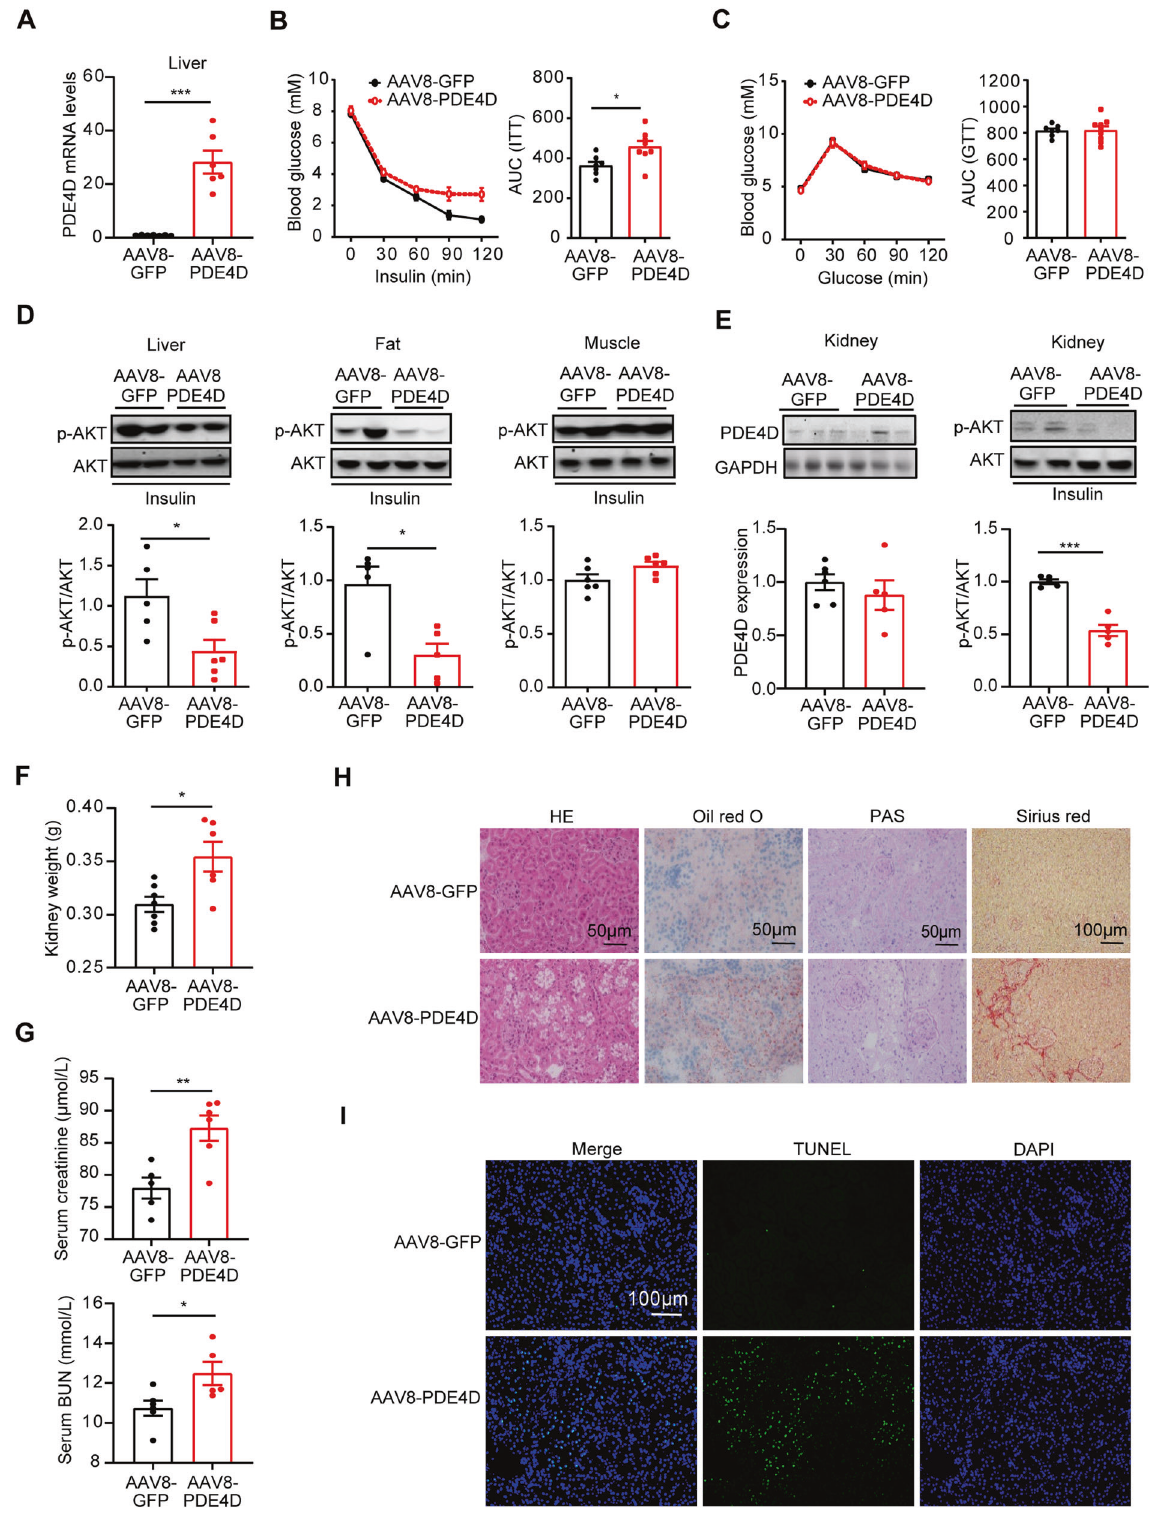
Fig. 4 Adeno-associated virus-mediated overexpression of PDE4D exacerbated renal injury. AAV8-PDE4D- and AAV8-GFP-treated mice were fed normal chow for 4 weeks. A The relative mRNA levels of PDE4D in the livers of the two groups. B , C ITT ( B ) and GTT ( C ) were performed on the AAV8-GFP and AAV8-PDE4D groups at week 4, and the AUCs of GTT and ITT were calculated. D Phosphorylation of AKT in liver (left), epididymal fat (center), and gastrocnemius muscle (right) after mice were injected with insulin for 15 min ( n = 5 – 6). E The protein levels of PDE4D and p-AKT/AKT in kidney tissue of AAV8-GFP and AAV8-PDE4D mice ( n = 5 – 6). F Kidney weight of the two groups of mice. G Serum creatinine and BUN levels of the two groups of mice. H HE, Oil red O, PAS, and Sirius red staining of mouse kidney. I TUNEL staining in kidney tissue of AAV8-GFP and AAV8-PDE4D mice. Data are means ± SEMs. * P < 0.05, ** P < 0.01, *** P < 0.001 with a two-tailed Student ’ s t test.